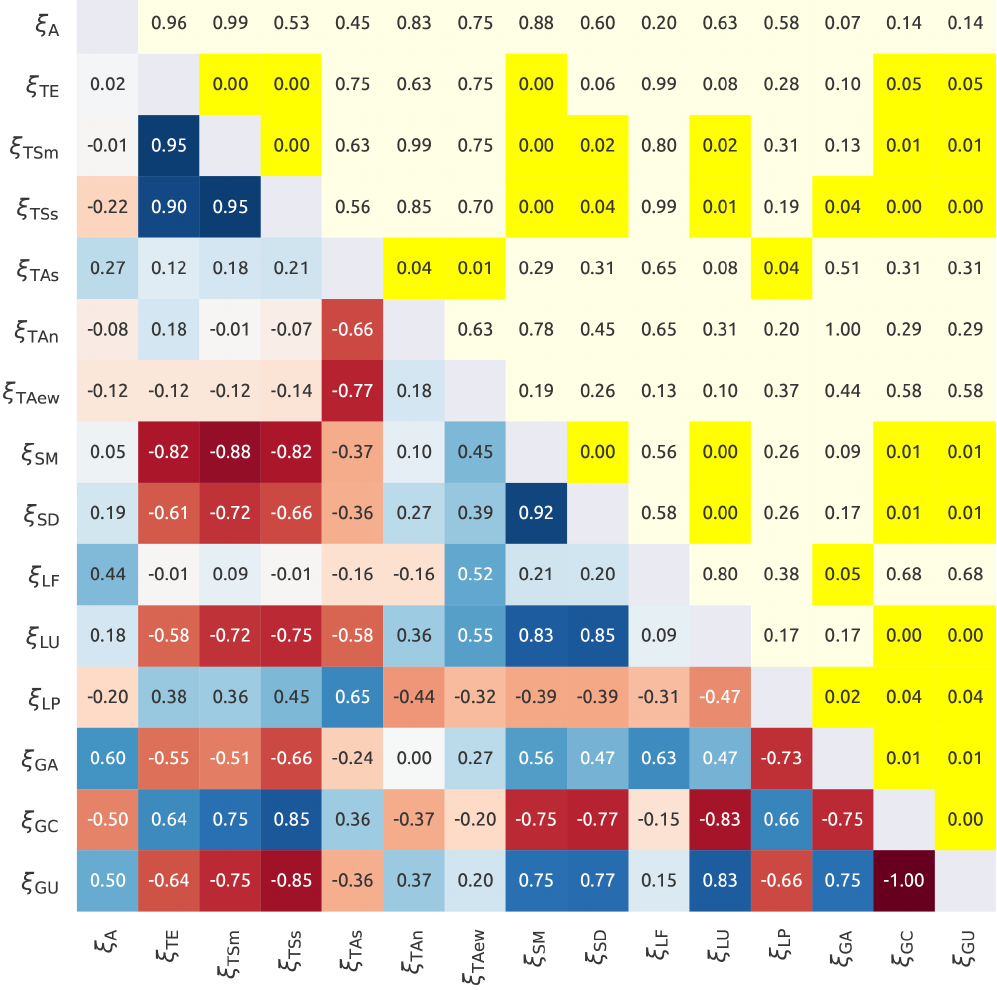
Figure 4. Internal correlation between the catchment characteristics. The lower triangle shows Spearman’s rank score with the red colour that indicates negative correlations and the blue that indicates positive correlations. The upper triangle reports the corresponding p values, where yellow colour indicates a statistically significant correlation ( p value < 0.05). The symbols used in the figure are reported in Table